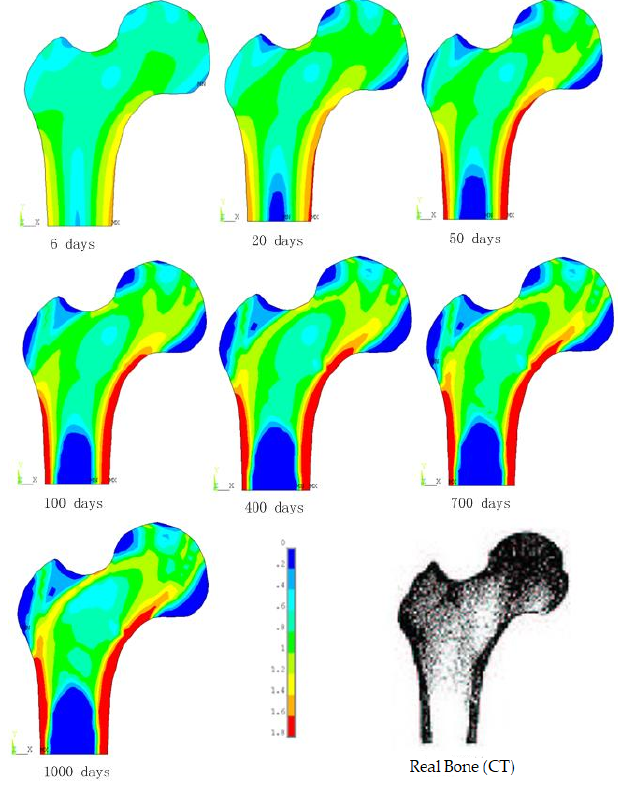
Fig. 4 Bone density change in the